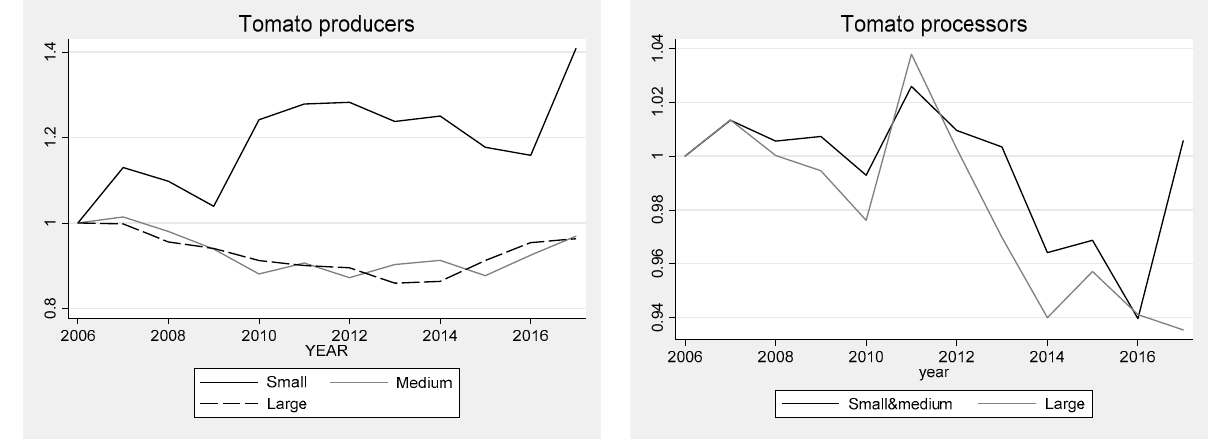
Figure 9. TFP dynamics according to the size (2006=100). Source: authors’ calculations.